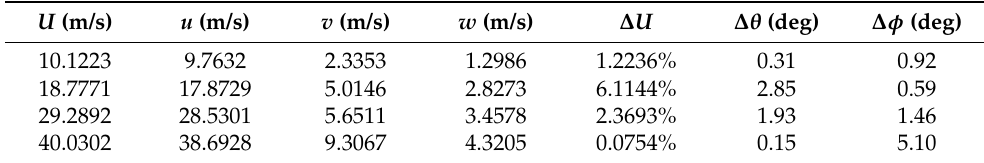
Table 2. Test results and errors.